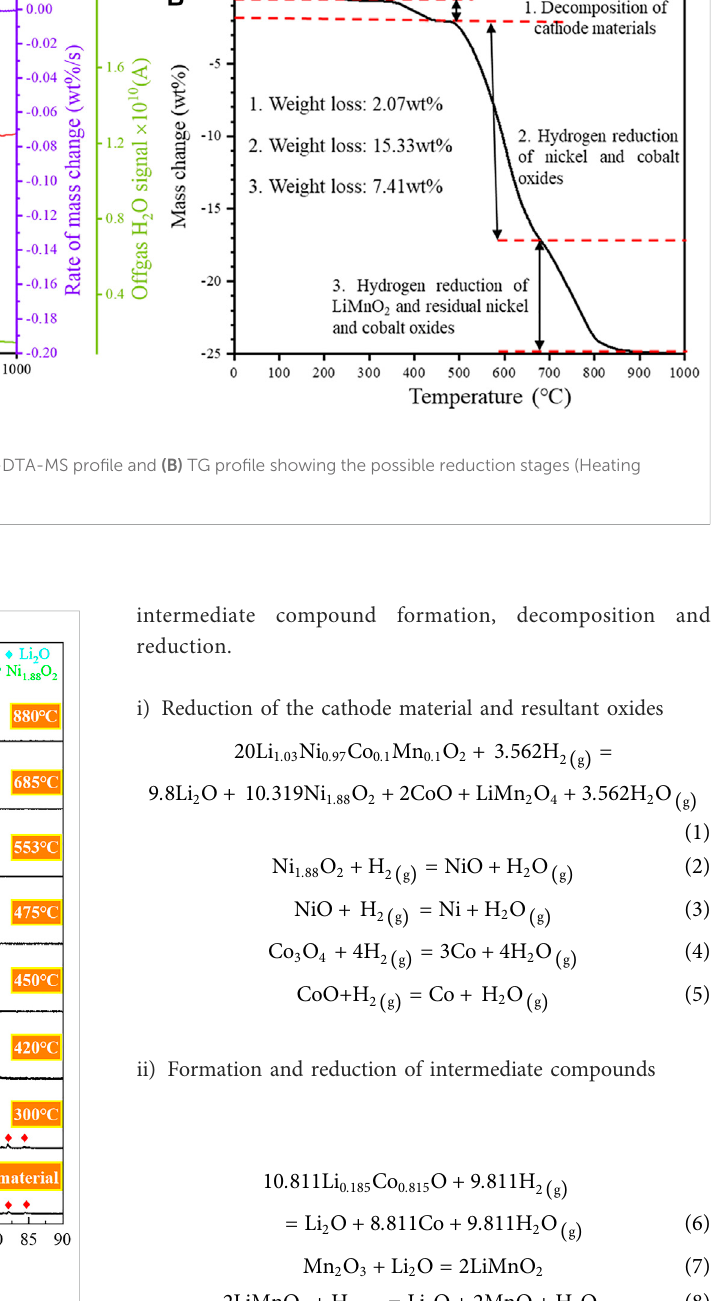
FIGURE 3 X-ray diffractograms of the reduction products obtained at intermediate reduction temperatures under non-isothermal reduction conditions (Heating rate 20 ° C/min, Hydrogen concentration 20 vol% H 2